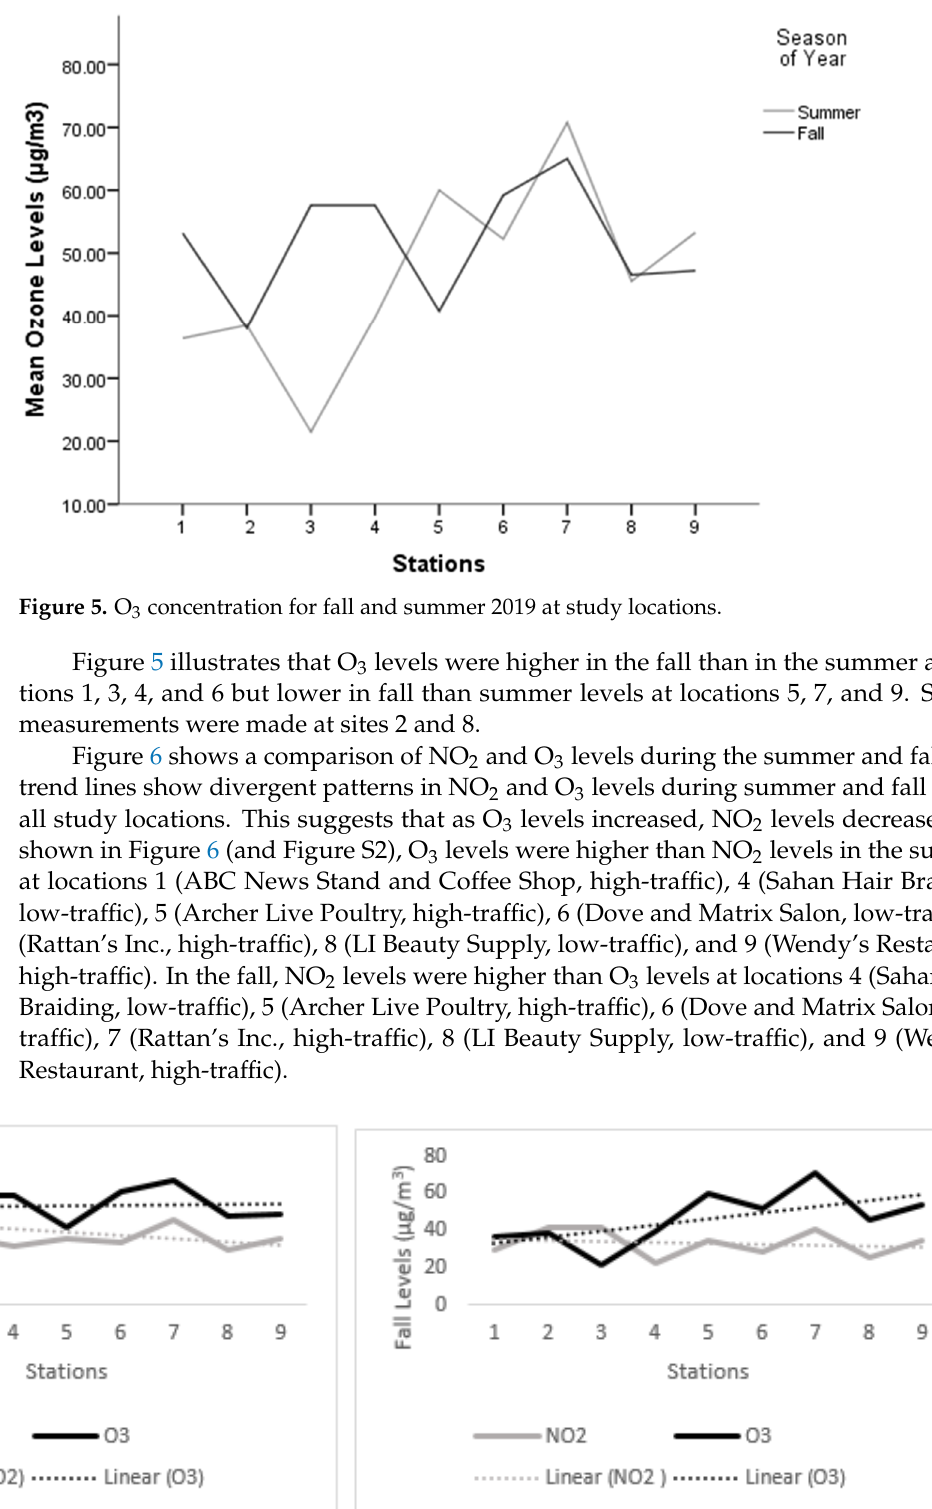
Figure 6. NO 2 and O 3 concentrations across the study centers. Fall season on the left and summer season on the